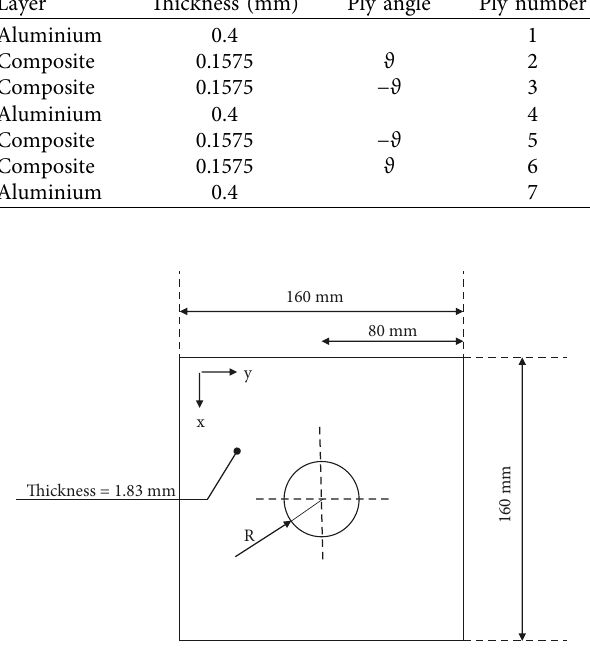
Figure 4: Geometry of the laminate